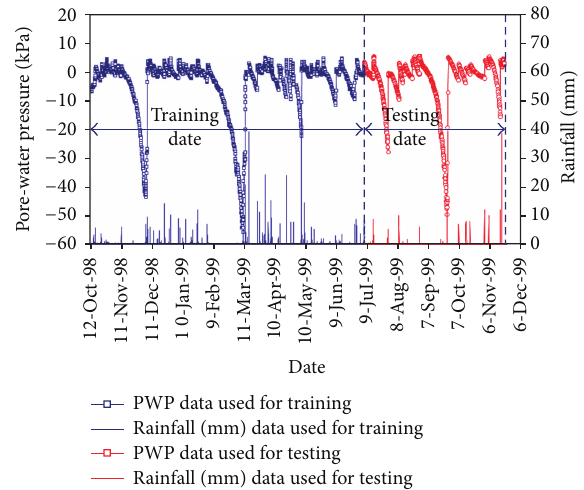
Figure 3: A trace of time series of rainfall and pore-water pressures at 0.5 m soil depth showing pore-water pressure responses to climatic changes. (Data ranges used for training and testing of the ANN model are shown in figure